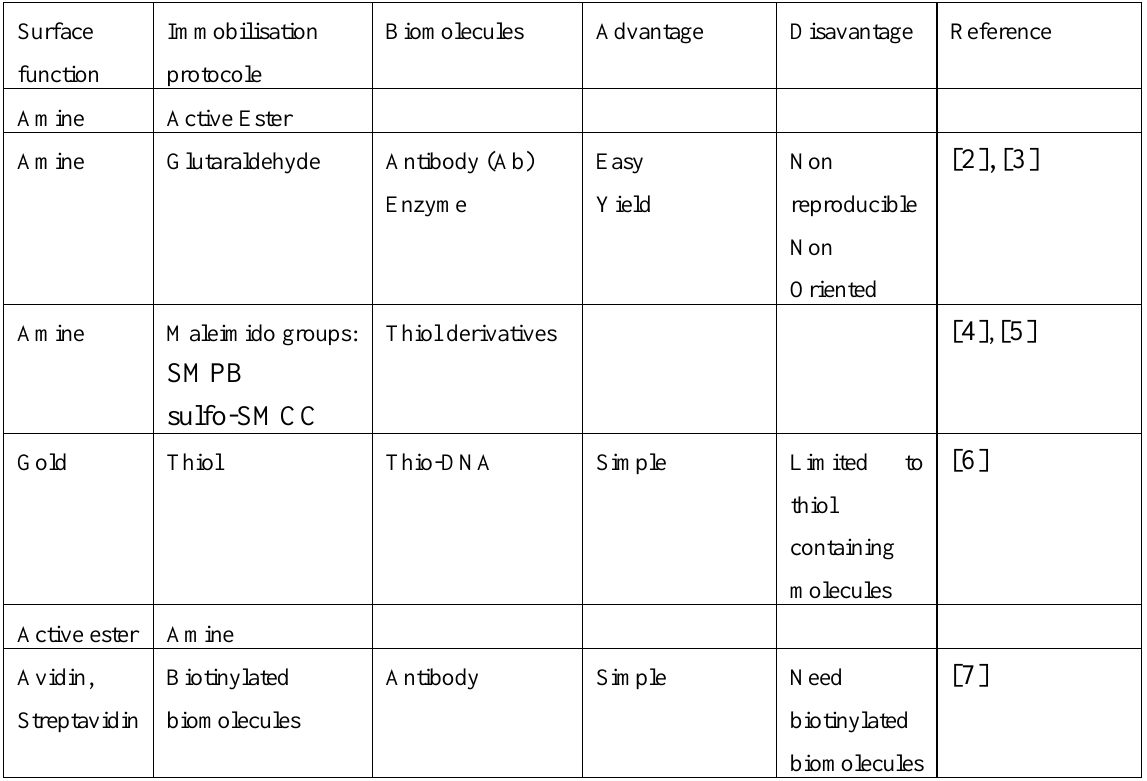
Table 1. Immobilisation protocoles of biomolecules used to our knowledge on nanobeads.